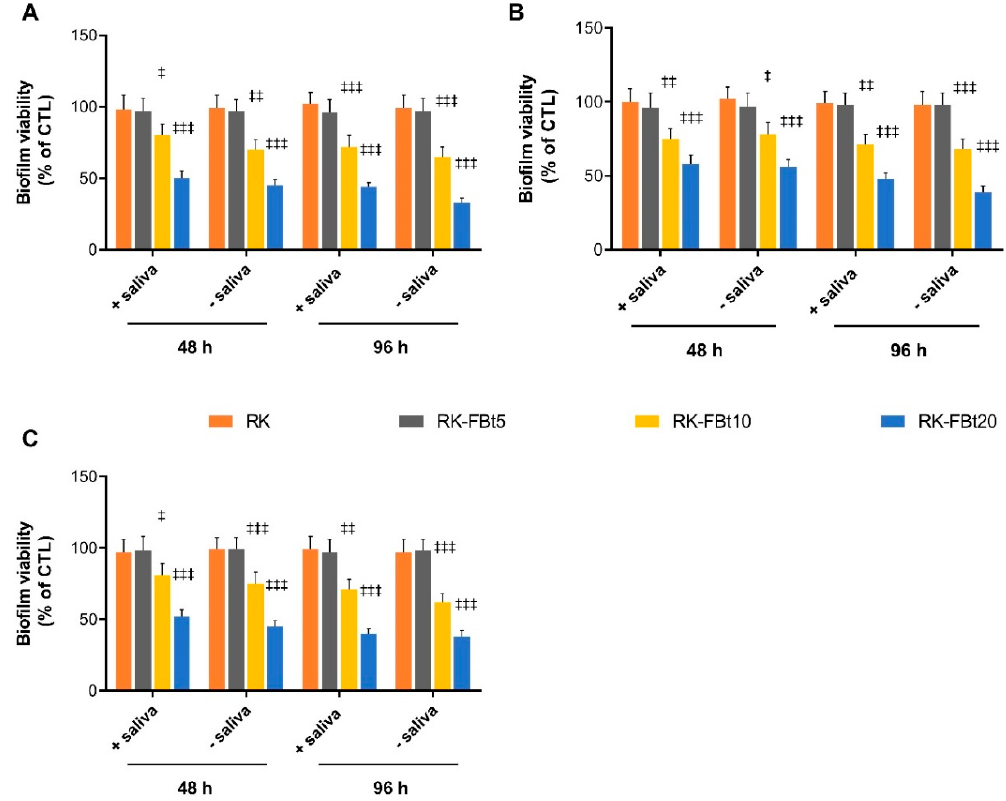
Figure 13. Antibiofilm activity of composite resins. Biofilm viability was evaluated by MTT assay, simulating or not the formation of salivary pellicle, after 48 and 96 h of incubation at 37 °C in the presence of Streptococcus spp. ( A ), B. fragilis ( B ), and S. epidermidis ( C ) as described in the Material and Methods section. The absorbance of each well was read at 510 nm. Biofilm formation was reported as a percentage in comparison with the maximum amount of biofilm produced by Streptococcus spp., B. fragilis , and S. epidermidis grown (positive controls). For each sample, six different experiments were conducted, and the results expressed as the mean of the values obtained (mean ± SD). Statistically significant variations: # P < 0.05, ## P < 0.01, and ### P < 0.001 versus positive control RK and RK-FBt5.